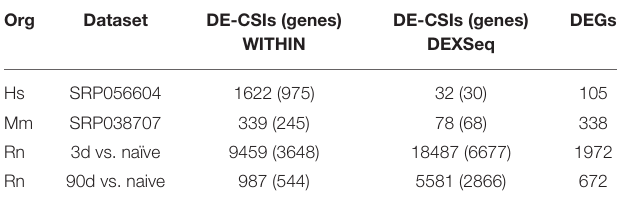
TABLE 6 | Differentially expressed events